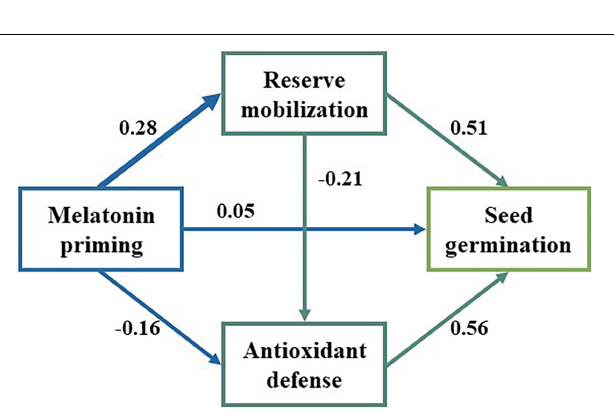
FIGURE 5 | The structural equation model (SEM) analysis was performed to evaluate the effect of the influential pathways of melatonin priming on reserve mobilization, antioxidant activity (SOD and POD) and seed germination. The arrows indicate the assumed pathways. The arrow width is proportional to the strength of the pathways. The number on the arrow is the path coefficients ( χ 2 = 4.311, dfp = 2, p = 0.116, CFI = 0.995, RMSEA =